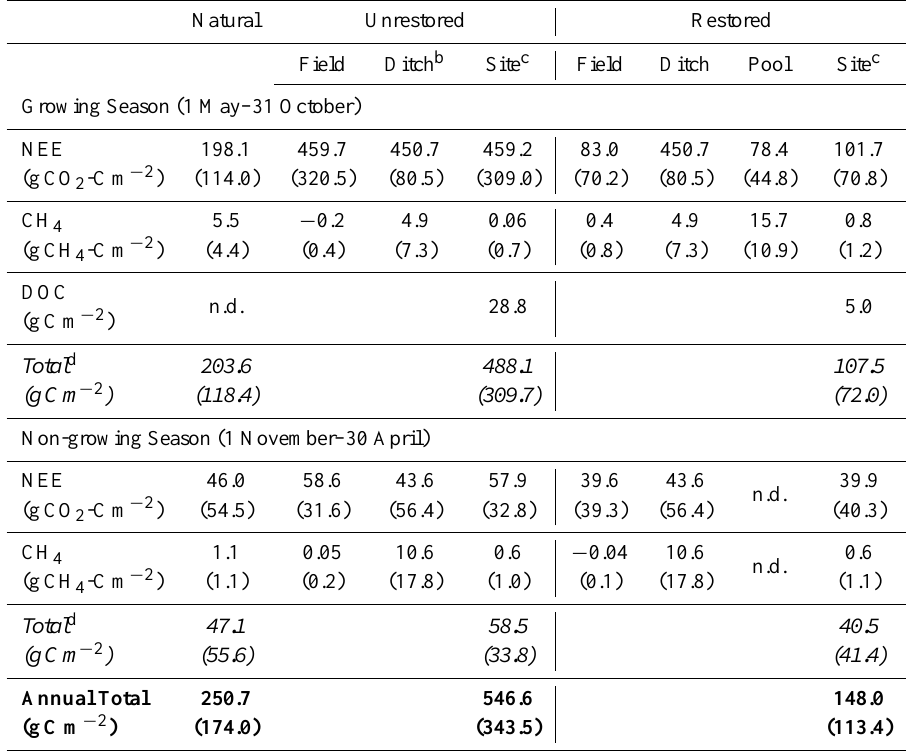
a Values are the mean of all measurements plots with standard deviation given in brackets. Natural site, n = 6 ; unrestored field, n = 6 ; ditches, n = 3 ; pools, n = 3 ; restored field, n = 14